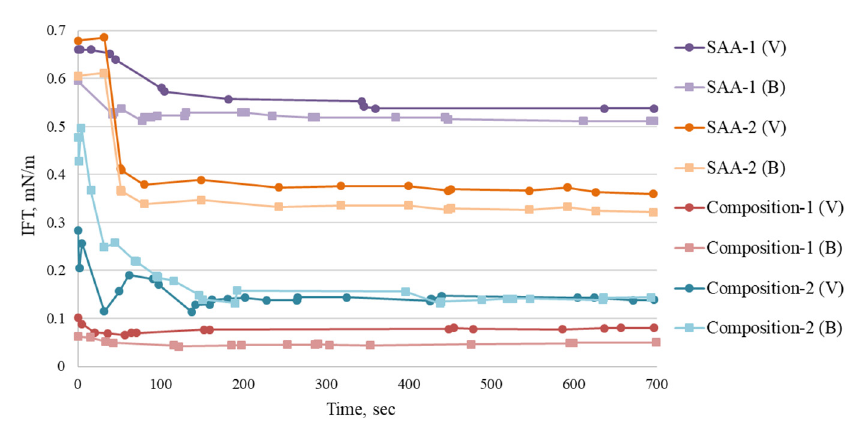
Figure 4. IFT measurements of 0.3% surfactant solutions. Square dots—Bashkirian stage, round dots—Vereian horizon.